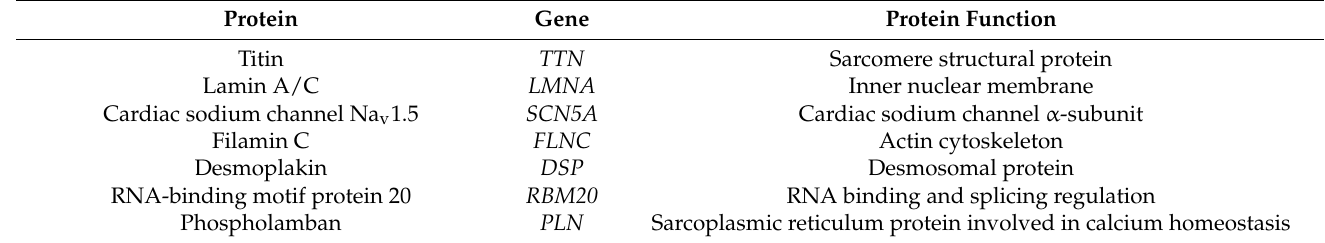
Table 1. Monogenetic causes of DCM particularly prone to ventricular